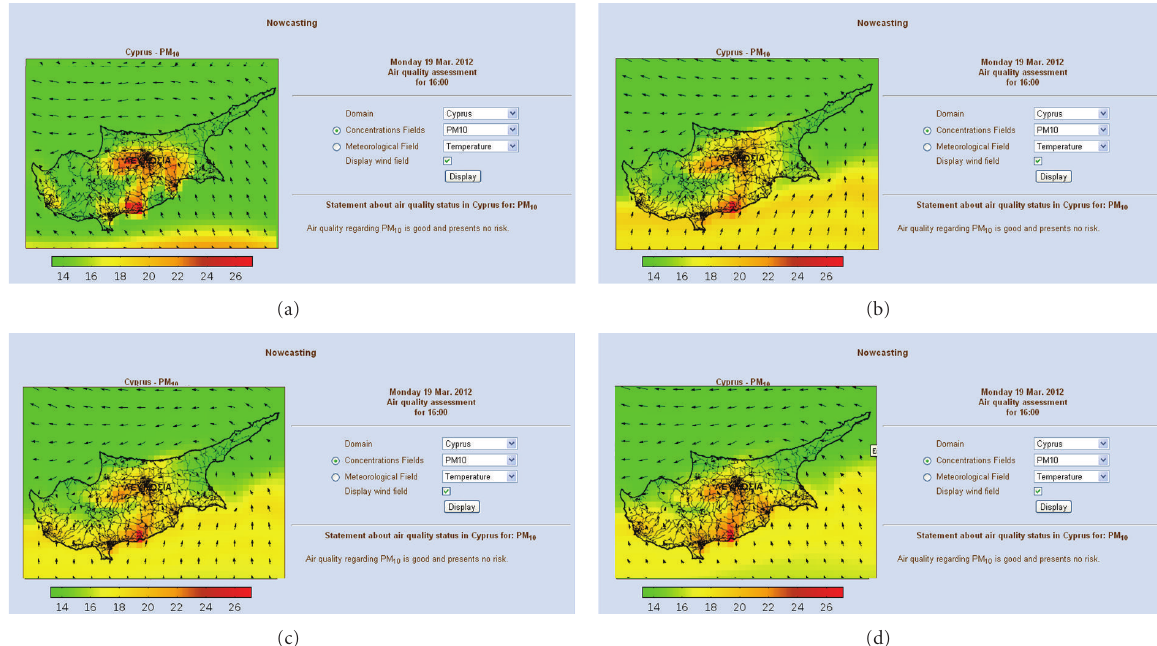
Figure 3: Snapshots of nowcasting results for PM 10 during a Saharan dust episode.